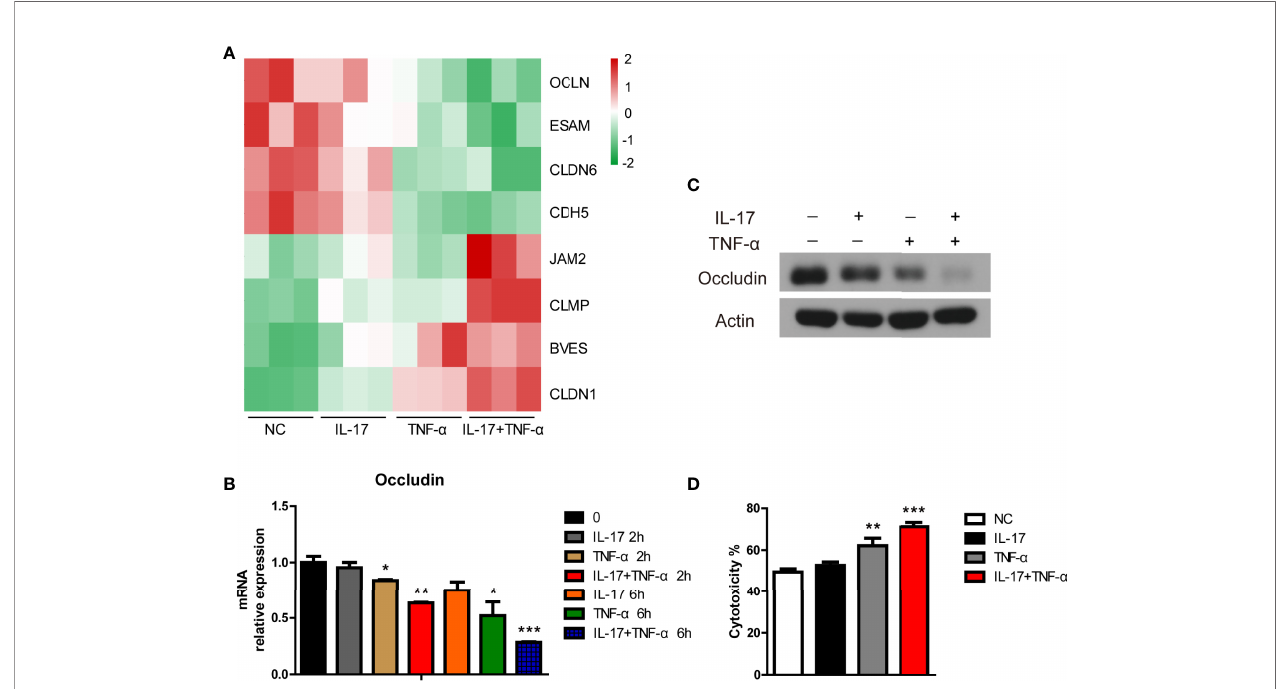
FIGURE 5 | IL-17 increased TNF- a -mediated cytotoxicity toward porcine aortic endothelial cells (PAECs) in a human antibody-mediated complement-dependent cytotoxicity model. (A) Heat map showing tight junction genes among the additive or synergistic genes in the control group, IL-17 group, TNF- a group, and IL-17 plus TNF- a group. (B) The PAECs were treated with rhIL-17 (100 ng/ml), rhTNF- a (2 ng/ml), or rhIL-17 plus rhTNF- a for 0, 2, or 6 h. The mRNA level of occludin was measured via real-time PCR. (C) The PAECs were treated with rhIL-17 (100 ng/ml), rhTNF- a (2 ng/ml), or rhIL-17 plus rhTNF- a for 24 h. The lysates were analyzed by western blotting with antibodies against occludin and actin. (D) The PAECs were treated with rhIL-17 (100 ng/ml), rhTNF- a (2 ng/ml), or rhIL-17 plus rhTNF- a for 24 h and then exposed to human serum to induce antibody-mediated CDC. Data are representative of at least three independent experiments (mean ± SEM). * p < 0.05, ** p < 0.01, *** p < 0.001, determined by Student ’ s t